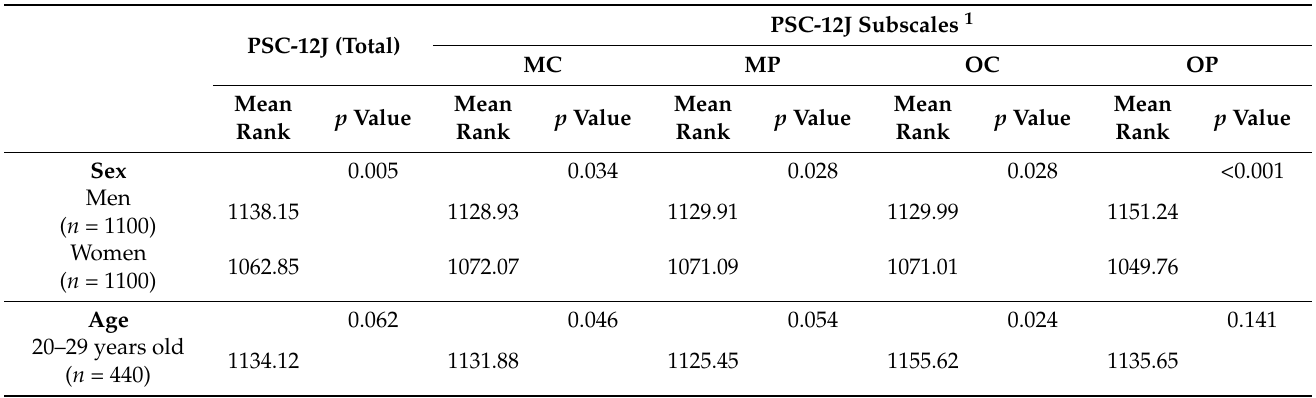
Table 5. Comparison of the mean ranks of the PSC-12J and its subscales by demographic characteristics (Kruskal–Wallis test) ( N =